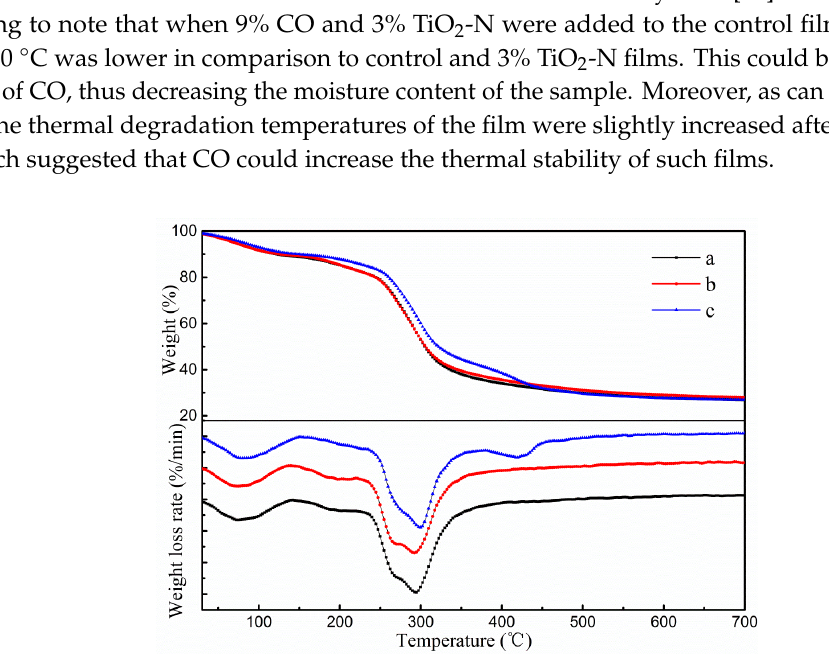
( d ) Figure 4. Appearance of different films. ( a ) Control; ( b ) 3% TiO 2 -N; and ( c , d ) 9% CO-3% TiO 2 -N. 3.2. Physico-Chemical Properties